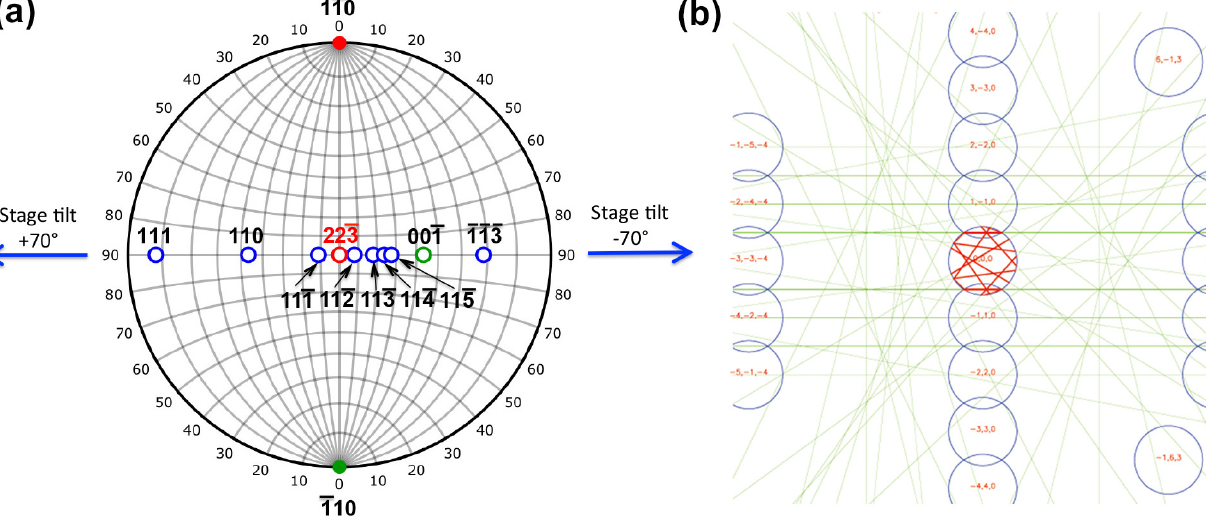
― ― ― ] β , and both 11 0 and 1 10 ― ] β